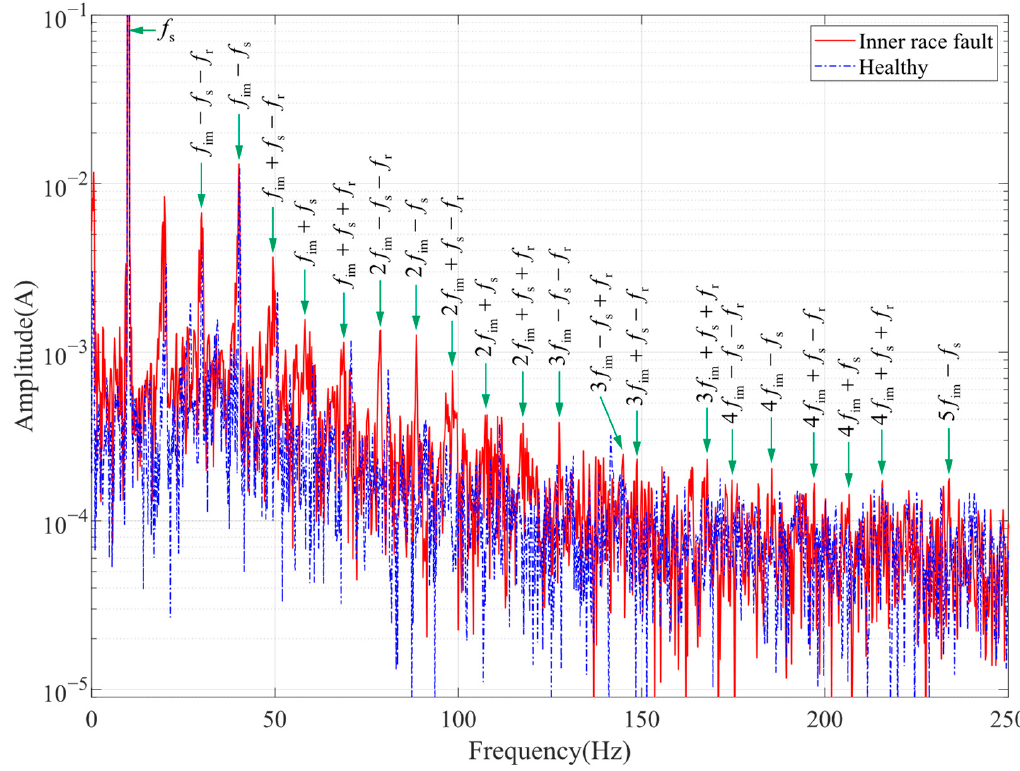
Figure 17. Comparison of stator current simulation signal spectrum under inner race fault (10 Hz).